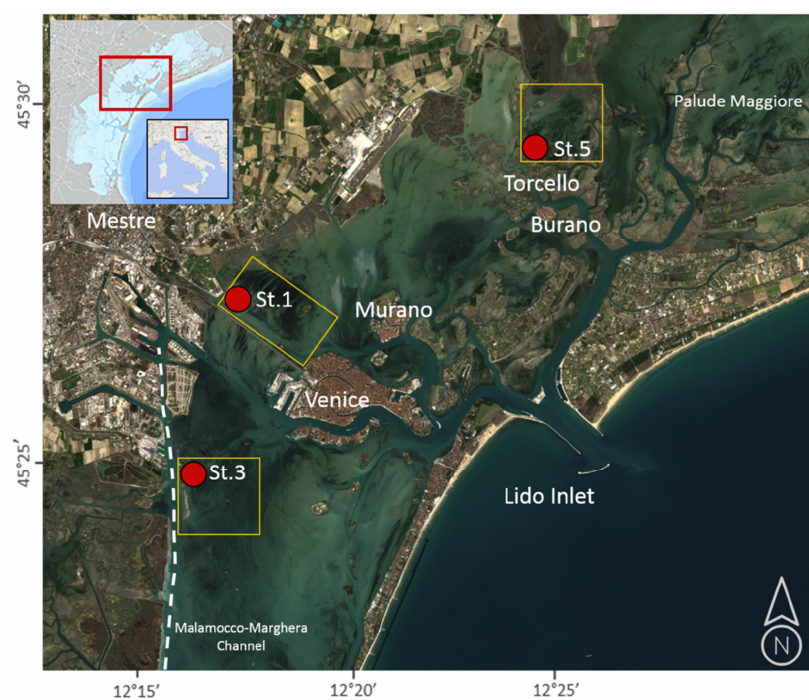
Figure 1. Copernicus Sentinel-2 (processed by European Space Agency) true-colour composite of the central area of the Venice Lagoon (19 March 2020) and the three sampling stations used for long-term data gathering.